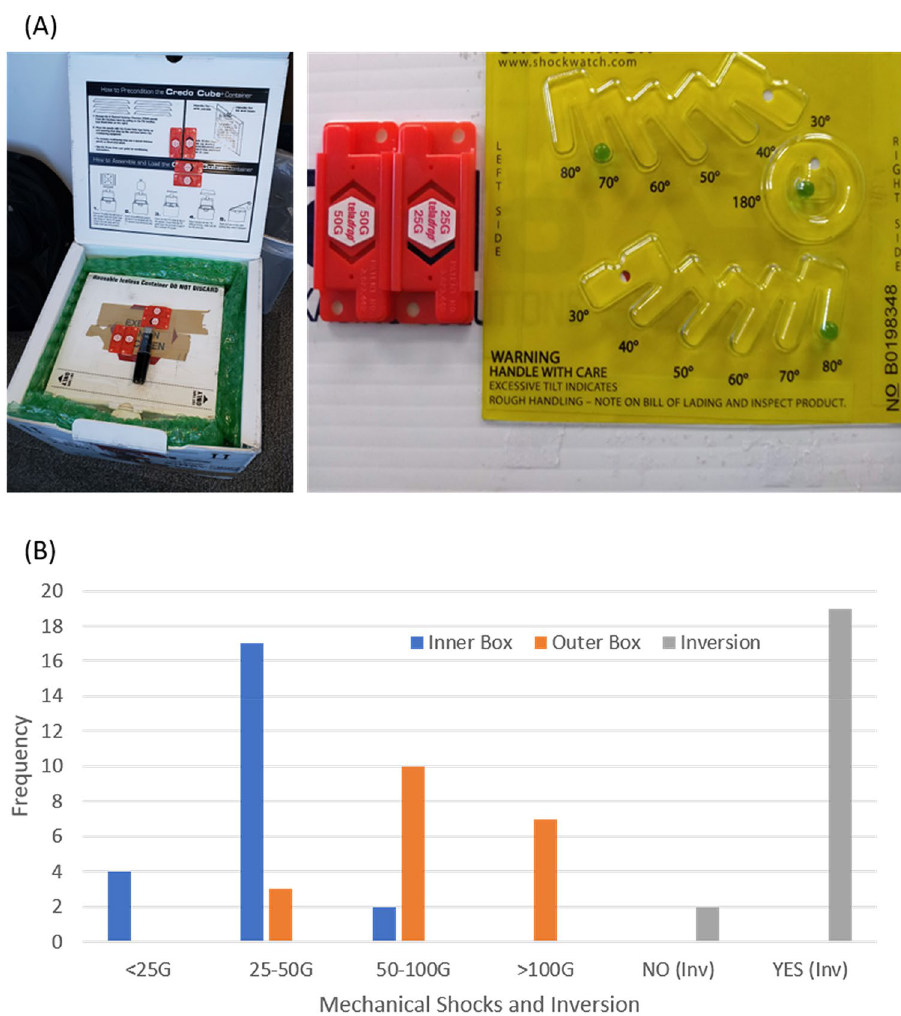
Figure 4. ( A ) Images of a µCRAIT box (with an outer box) and the Drop-N-Tell Shock Indicators and TiltWatch Plus used to monitor the mechanical shock and tilt of the box experienced during transportation; ( B ) mechanical shock G-range and inversion frequency from over twenty shipments between Phoenix, AZ and New York, NY by FedEx Express